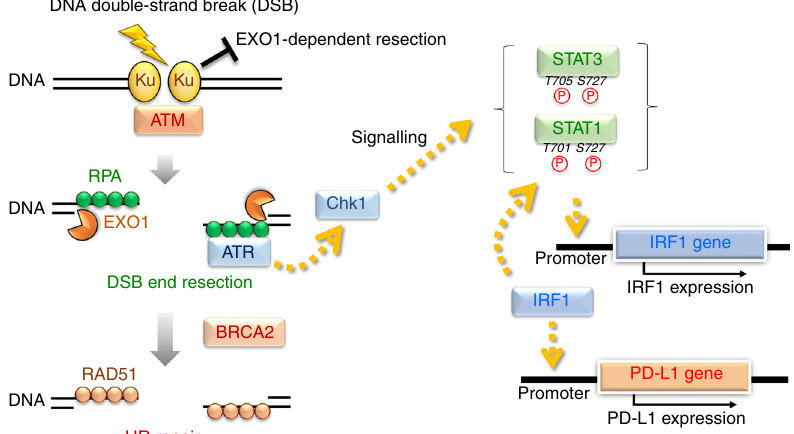
Fig. 7 Model for PD-L1 upregulation in response to DNA double-strand breaks. In the newly proposed model in the context of DSB repair pathway choice, the Ku70/80 complex binds rapidly to all the DSB ends, allowing NHEJ to make the fi rst attempt at repair immediately after IR 44, 46, 55 . The Ku70/80 complex promotes NHEJ, whereas it prevents unscheduled resection by blocking the access of DNA nucleases. DSBs also activate ATM, a central signal transducer. ATM then activates DNA end resection 45, 55 . ATR/Chk1 is activated onto the resected RPA-coated single-stranded DNA (ssDNA) and at the same time BRCA2 promotes the switch from RPA to RAD51 on ssDNA in the HR pathway. Thus, based on the repair switch model from Ku-binding to HR, our fi ndings suggest a defect in a DSB repair protein, i.e. a defect in either Ku70/80 complex or BRCA2 leads to the upregulation of PD-L1 expression via Chk1 activation following EXO1-dependent resection. Furthermore, we showed that STAT1/3 and IRF1 are activated in response to DSBs. Notably, PD-L1 upregulation requires IRF1, strongly suggesting that DSB-dependent PD-L1 upregulation is induced by the canonical STAT – IRF1 pathway